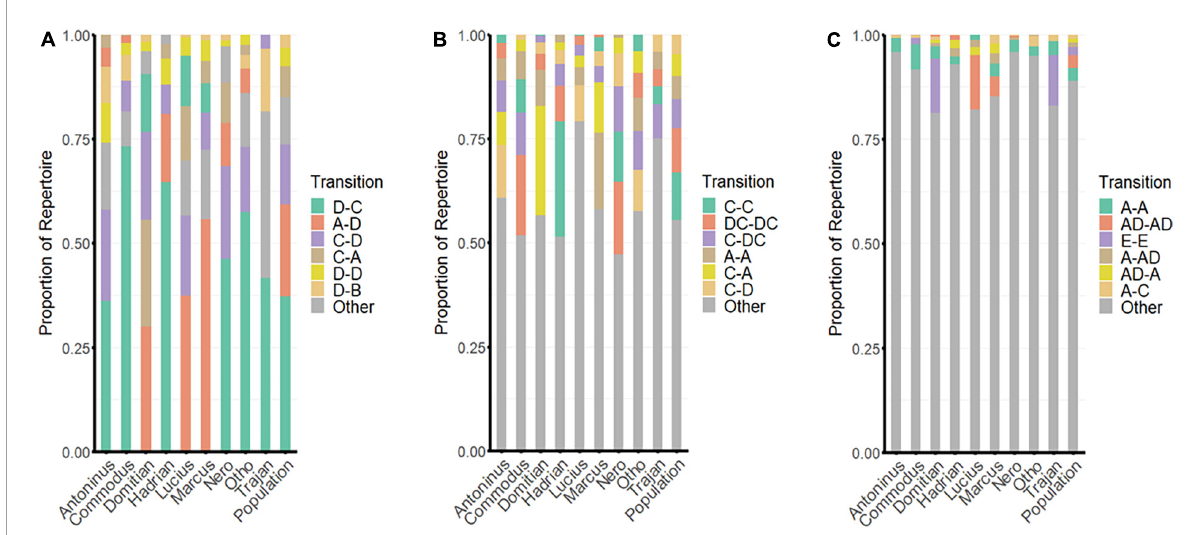
FIGURE4 The transitions most frequently used by each individual and by the population as a whole: (A) element to element transitions; (B) syllable to syllable transitions; and (C) phrase to phrase transitions. For phrase-phrase (C) , the six listed transitions exclude those containing unclassified elements; these are included under “Other”. Transitions are annotated as: A = trill; B = tone; C = upsweep; D = downsweep; and E =